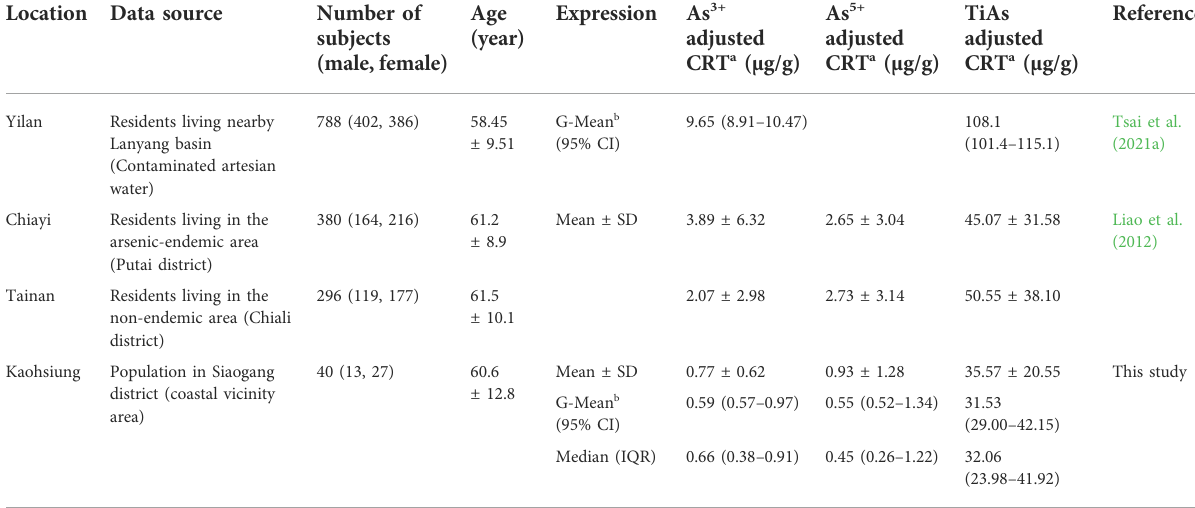
TABLE 4 Comparison of resident urinary arsenite (As 3+ ), arsenate (As 5+ ), and total inorganic-related arsenic (TiAs) levels in the previous As-endemic and nearby areas in Taiwan with this study. Location Data